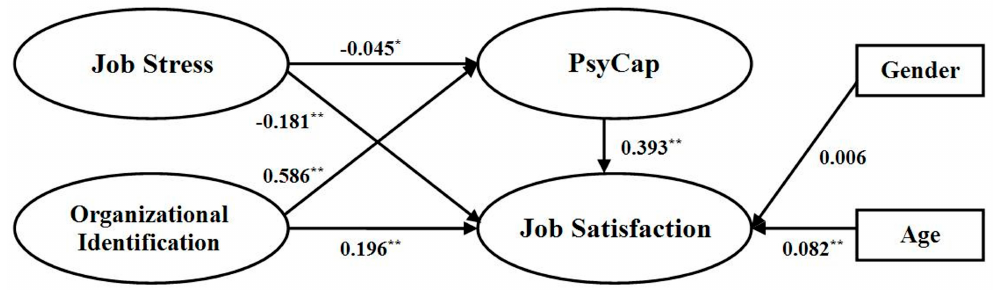
Figure 2. The final model with the mediating effect of PsyCap. Note: PsyCap: psychological capital; * p < 0.05; ** p < 0.01.